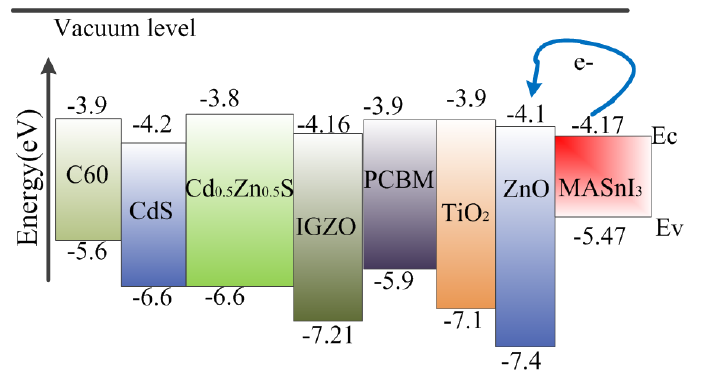
Figure 3. Effect of different ETL materials on QE. Table 4. Responses of PSCs with different ETL materials.